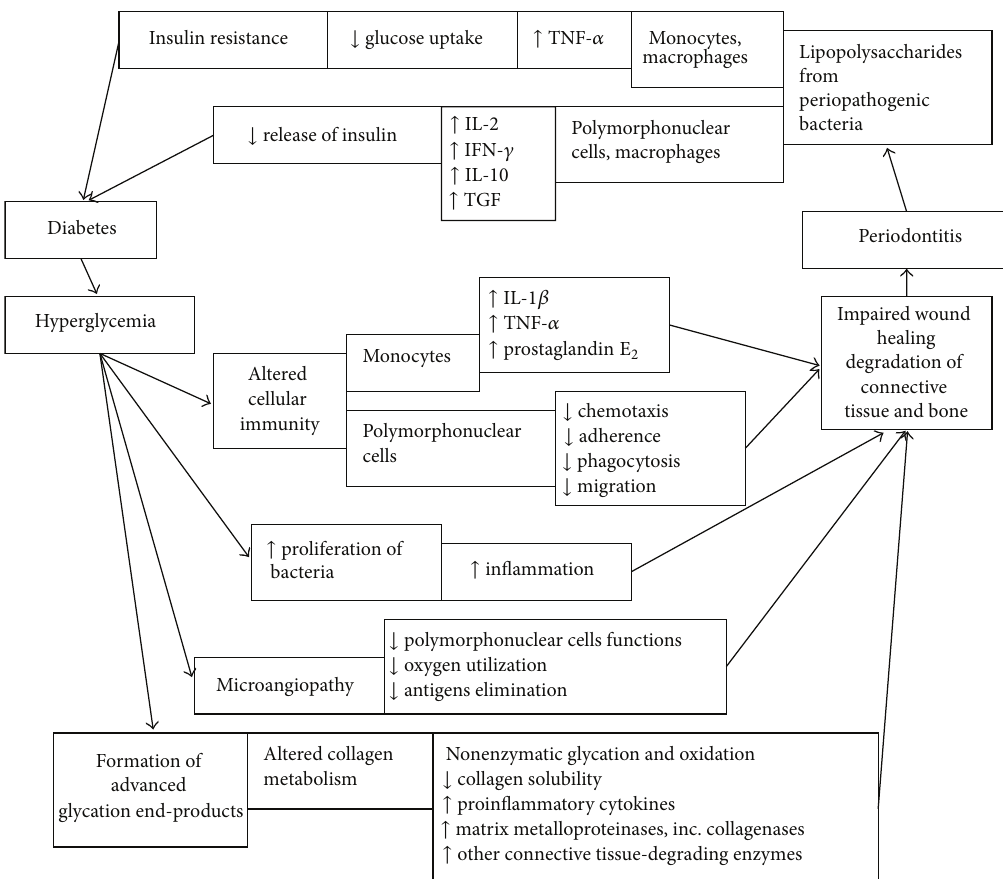
Figure 2: Associations between diabetes and